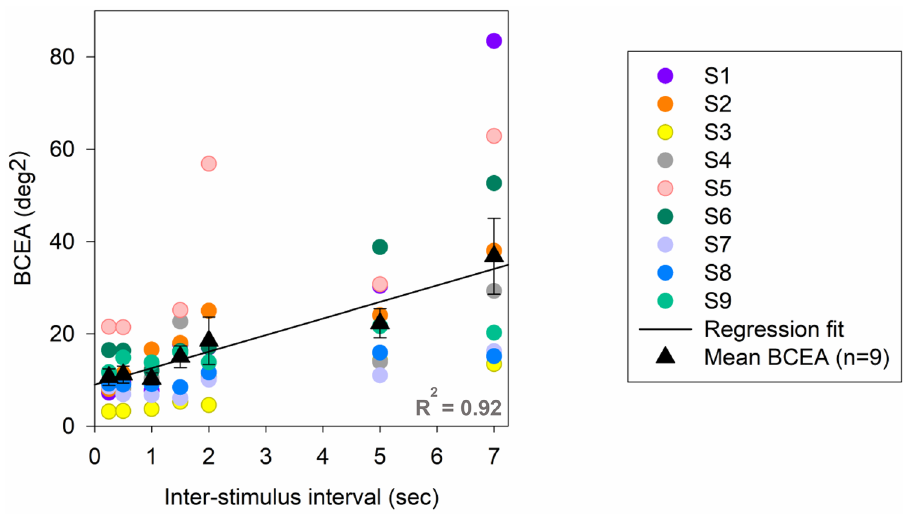
Figure 4. Relationship between BCEA and inter-stimulus interval. Black triangles represent the mean and standard error in BCEA across subjects. (n = 9). Each color represents the BCEA for a single subject. The black line denotes the linear regression